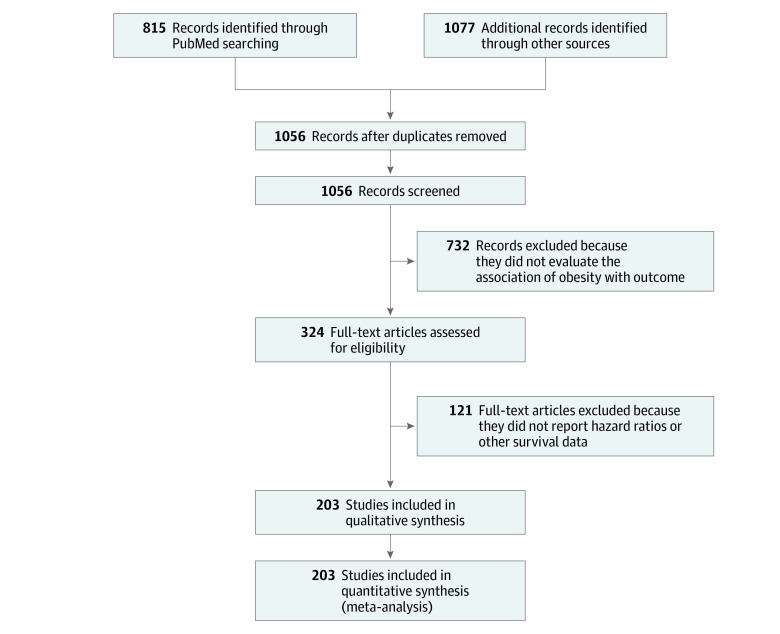
Flow Diagram of Included Studies